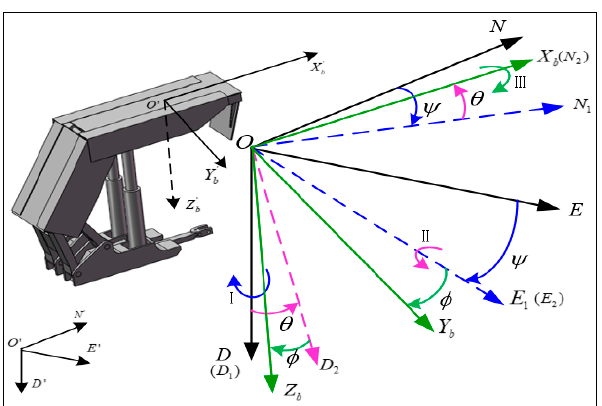
Figure 2. Coordinate transformation and directional cosine matrix definition of the canopy between frame b and frame n based on hydraulic support.